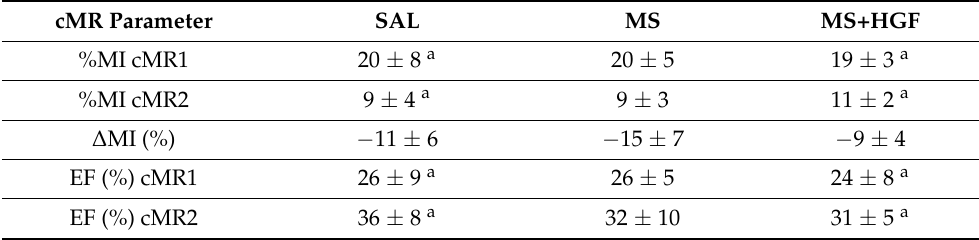
Table 7. Cardiac parameters calculated from Magnetic Resonance exams performed through the